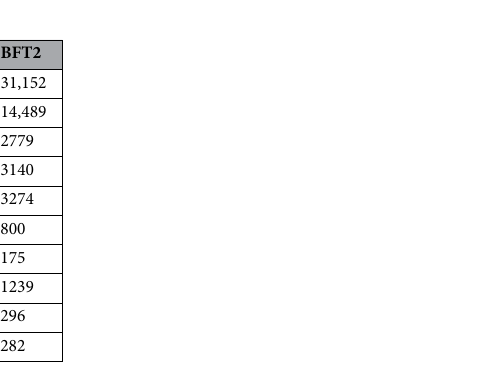
Table 2. Major Phyla abundance among the